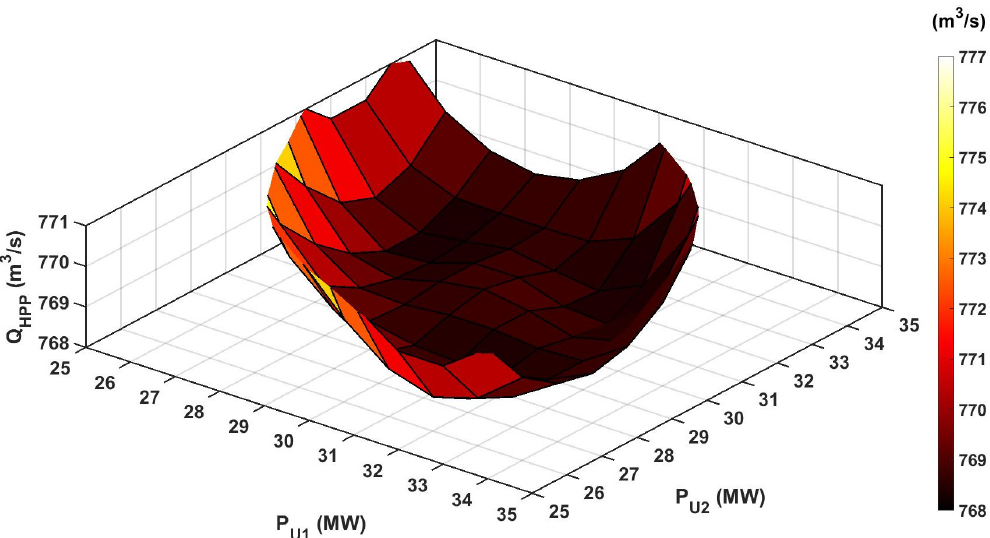
Figure 2. Water discharge for the HPP having 3 hydraulic units and a power output setpoint of 90 MW ( P U3 is calculated using Equation (7) for the given load schedule P S ).